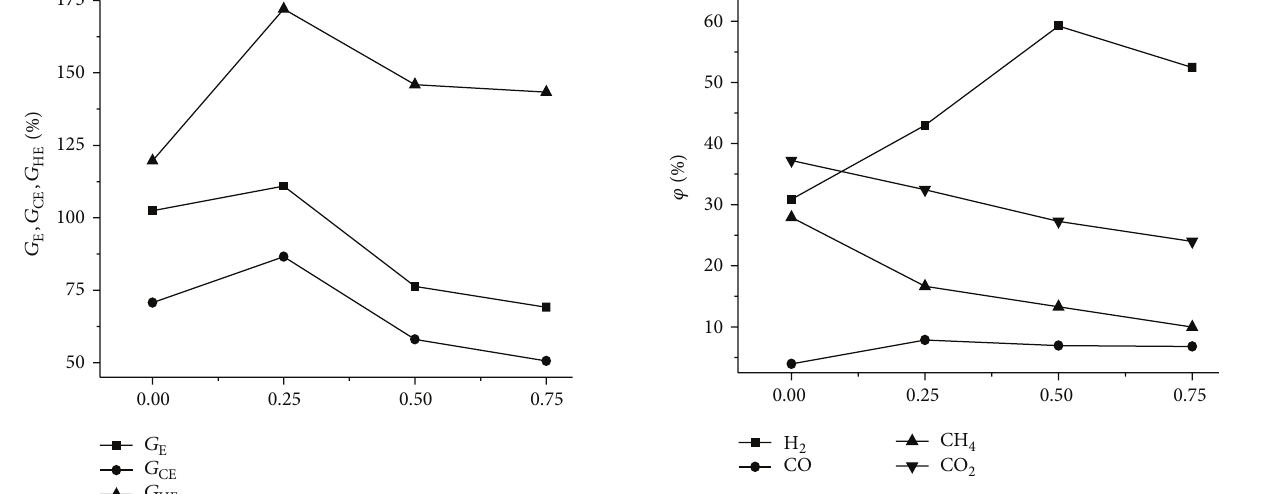
Figure 2: The influence of NaOH on the gas fraction (%) (water :CMC:biomass :Raney-Ni = 10g:0.3 g:01g:1g, tempera- ture: 400 ∘ C, and residence time: 20